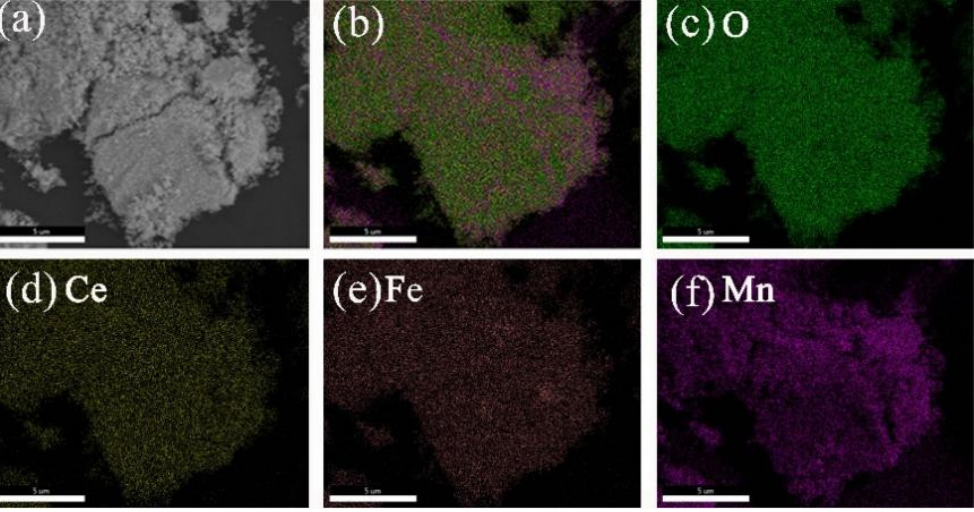
Figure 6. SEM image and EDAX element mapping distributions of Ce 0.2 -MF: ( a ) SEM image; ( b ) element overlay: ( c ) O, ( d ) Ce, ( e ) Fe, and ( f ) Mn.